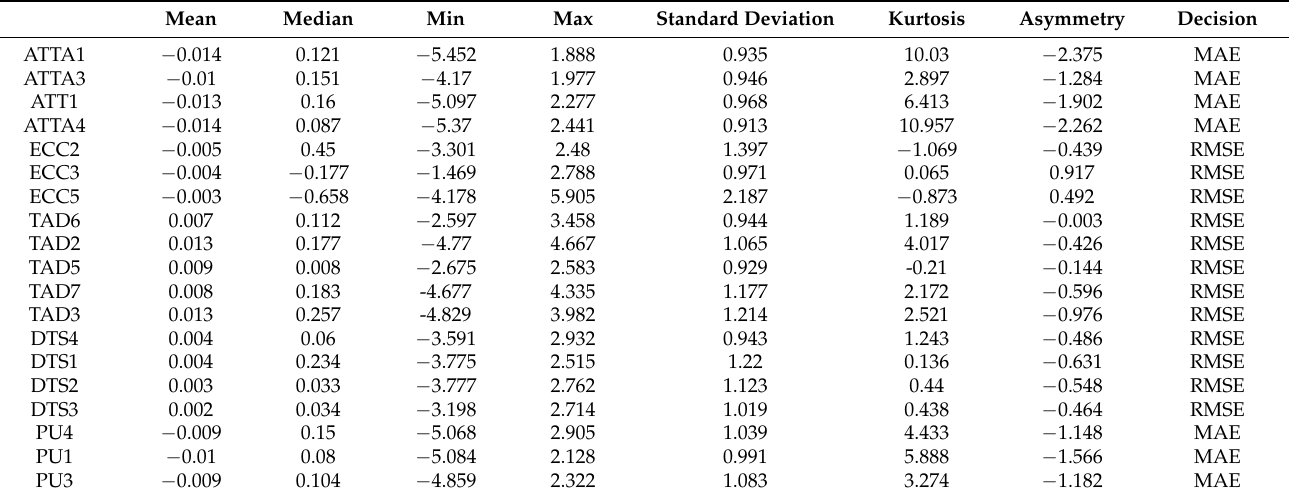
Table 17. Descriptive statistics and choice of the error prediction